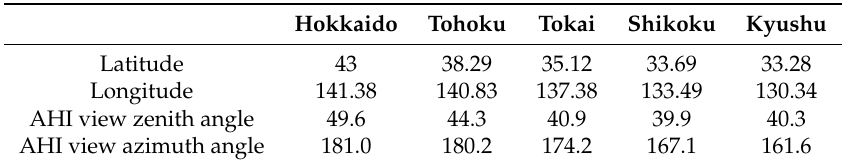
Figure 1. Areas of the regions of interest (ROI), including Hokkaido, Tohoku, Tokai, Shikoku, and Kyushu regions in Japan, demarcated by red parallelograms, from northeast to southwest over the SRTM30 Plus from the NASA WorldWind WMS (https://data.worldwind.arc.nasa.gov/elev?) [44]. Yellow crosses indicate the points at which the MODIS scene was extracted in the first data extraction step. Their coordinates and view angles of Advanced Himawari Imager (AHI) for the points are summarized in Table 1. Table 1. Geographic coordinates used to explore the Moderate Resolution Imaging Spectroradiometer (MODIS) data and AHI view angles for each coordinate in